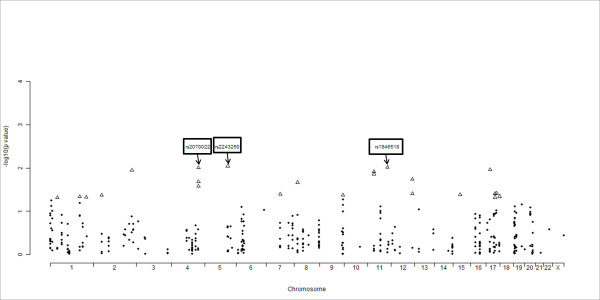
Chromosome distribution for association of SNPs with Type 2 Diabetes. In this panel, Manhattan plot shows distributed variables that were generated by genome-wide significance (p-values). Triangle markers at each locus indicate the significant SNPs based on a chi-squared test (p value < 0.05). Boxed SNPs represent Top 3 ranked lists.